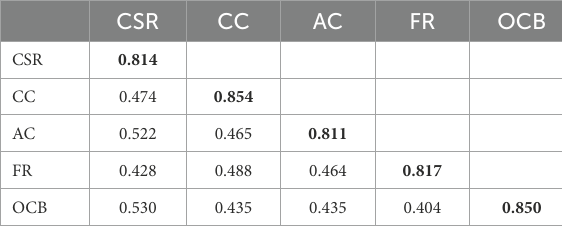
TABLE 4 Discriminant validity (Fornell and Larcker criterion).